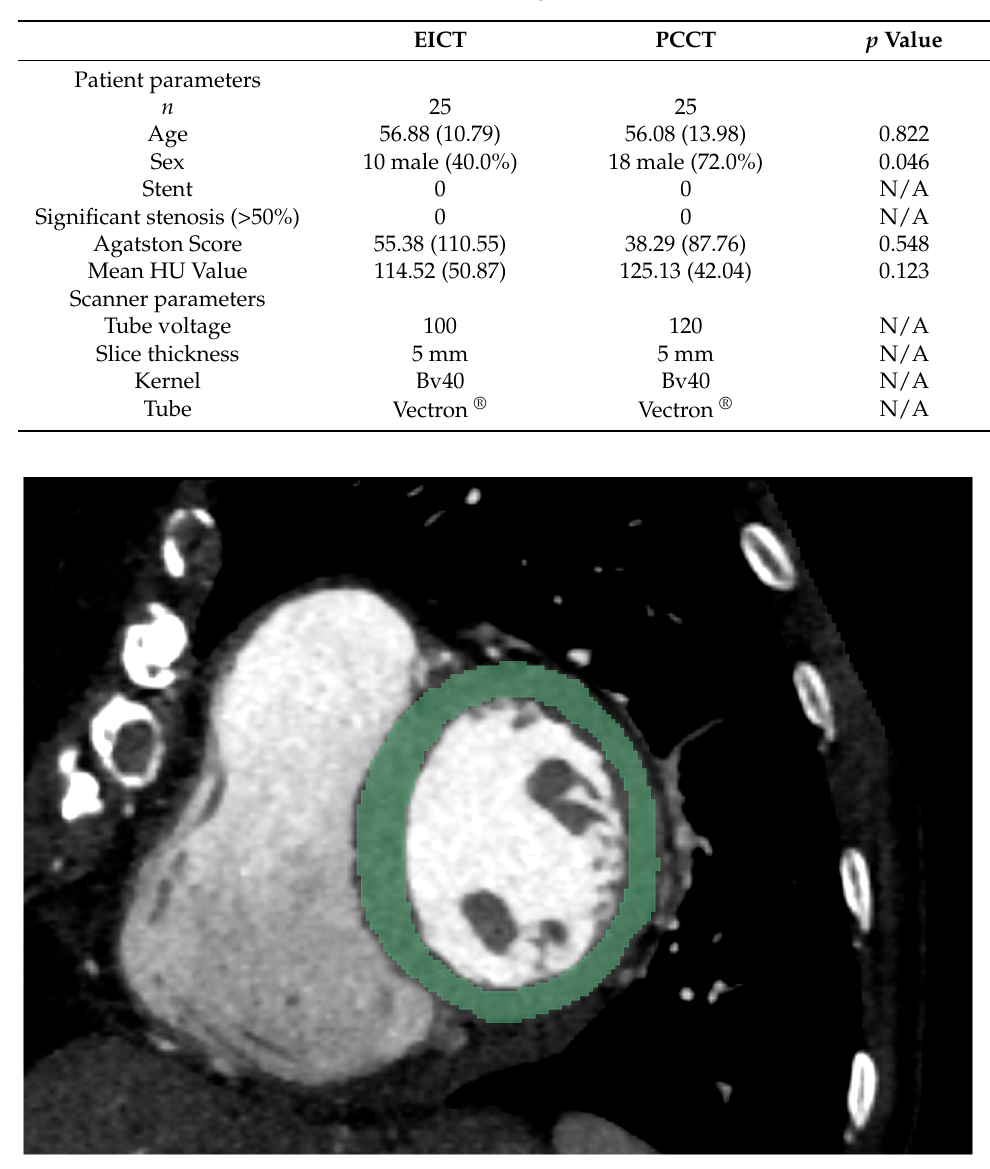
Table 1. Patient collective overview. Mean and (SD) given for continuous variables.